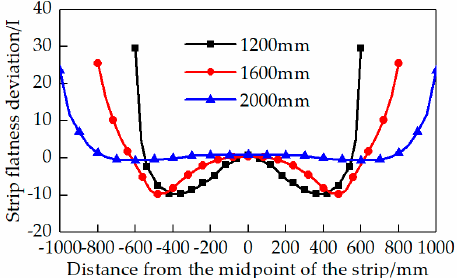
Figure 15. The effect of different widths on the flatness calculation deviation.